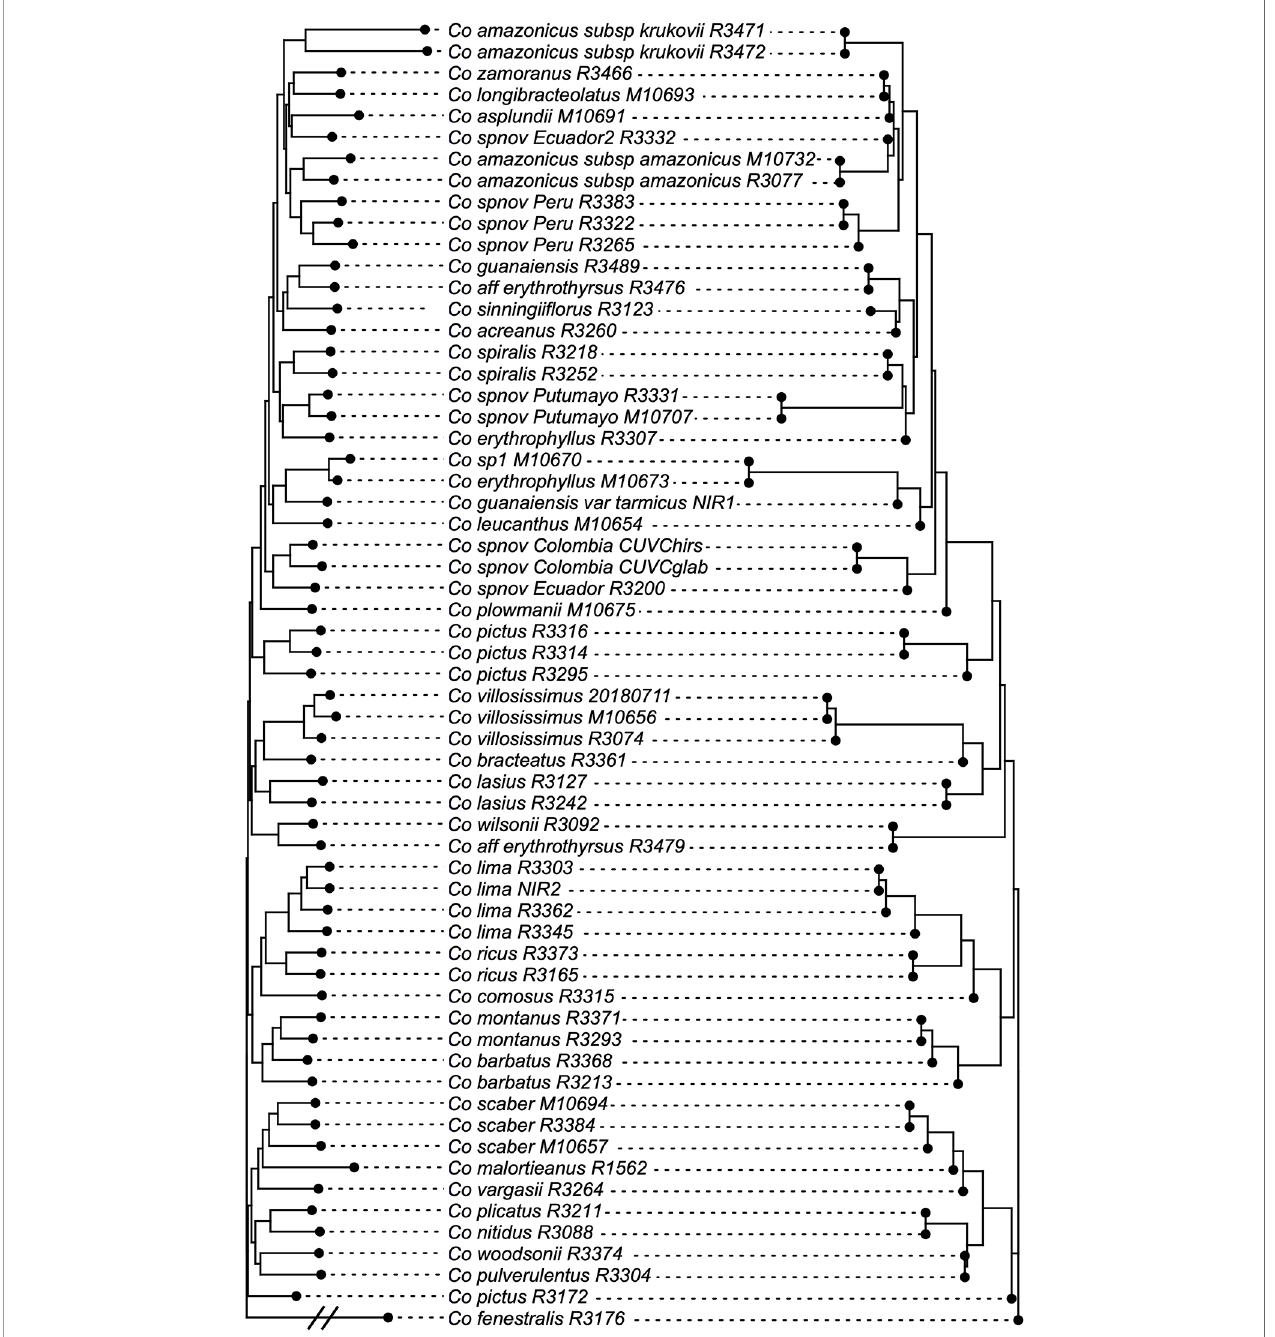
FIGURE 6 | Topologies obtained with concatenation v. coalescent-based species tree analyses, showing just one node difference between the two. Branch lengths proportional to the number of substitutions for the IQ-Tree result and to coalescent units in the ASTRAL